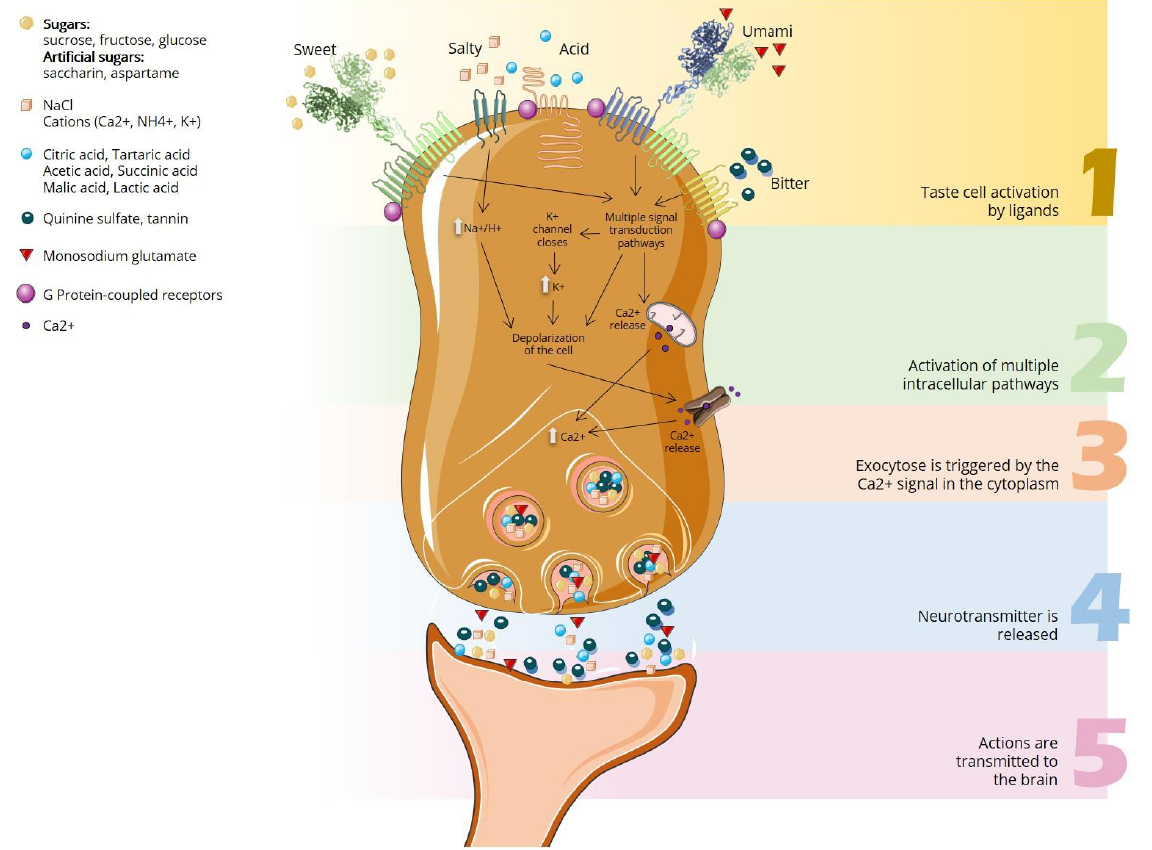
Figure 3. Generalized scheme of taste transduction. Tastants bind to specific receptors on the apical membrane. All stimuli elicit increases in intracellular Ca 2+ , either by activation of voltage-gated Ca 2+ channels or by causing the release of Ca 2+ from intracellular stores.